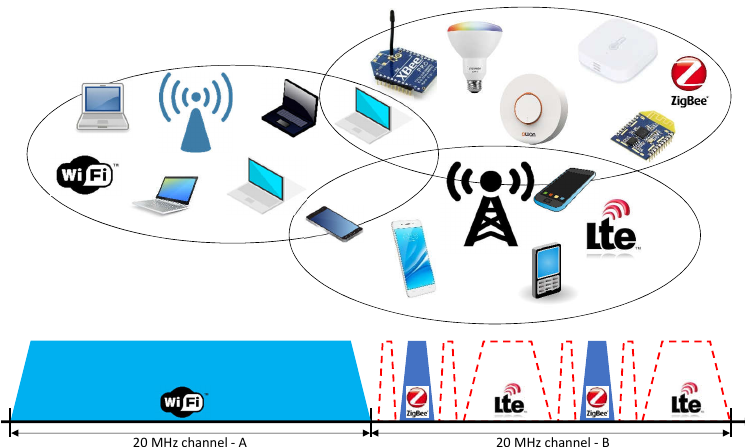
Figure 3. Flexible and dynamic spectrum access example. Communications spectrum bandwidths can be flexibly and dynamically changed according to the availability of spectrum as well as application requirements.